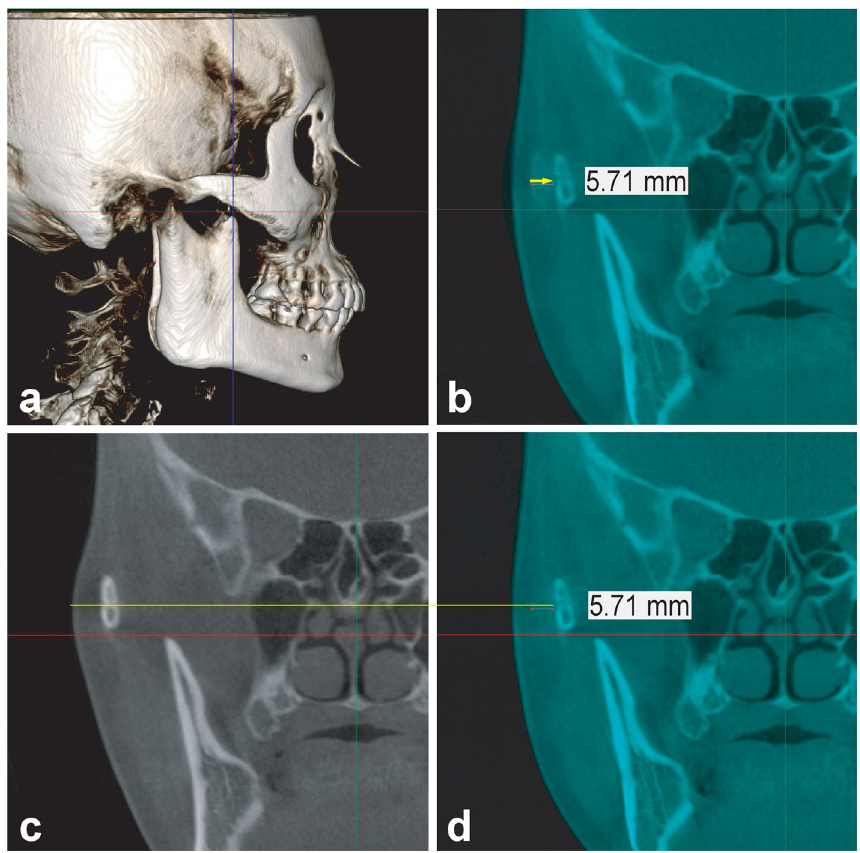
Fig. 3 Measurement of inward arch movement at the coronoid process in the coronal plane including the apex of the process. a Identification of the coronoid process apex. The yellow arrow in b and the number below the arrow indicate the direction and degree of horizontal reduction. The yellow lines in c and d show the most abundant soft tissue. Arch reduction was confirmed at the level of the soft tissue, including the apex, in the coronal